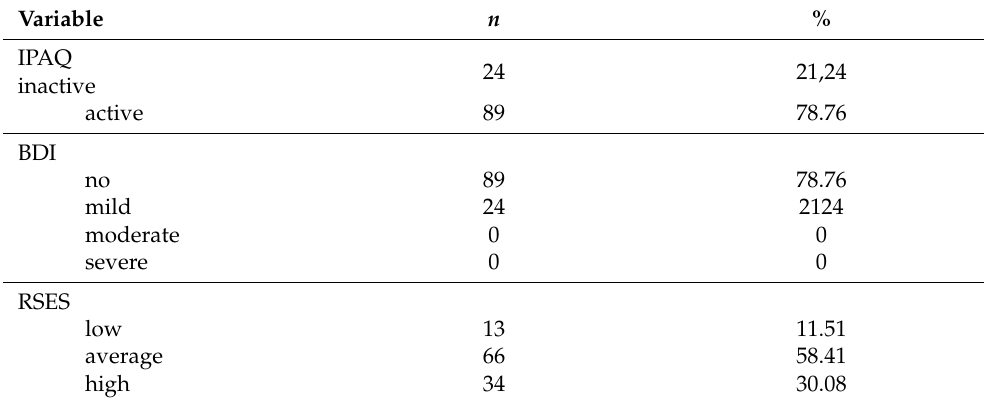
Table 2. Characteristics of the study group according to PA levels, depression symptoms and self-esteem.